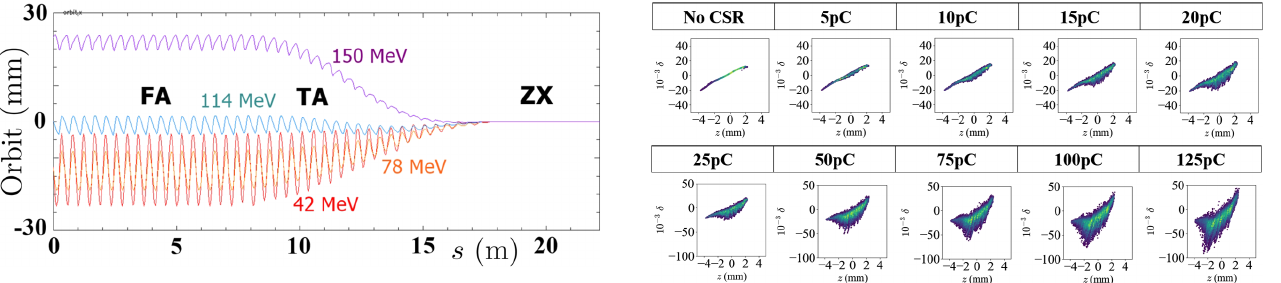
FIG. 25. The z − δ distribution after each of the 8 LINAC passes for CBETA 1-turn with various Q . Note that the two rows of plots have a different vertical